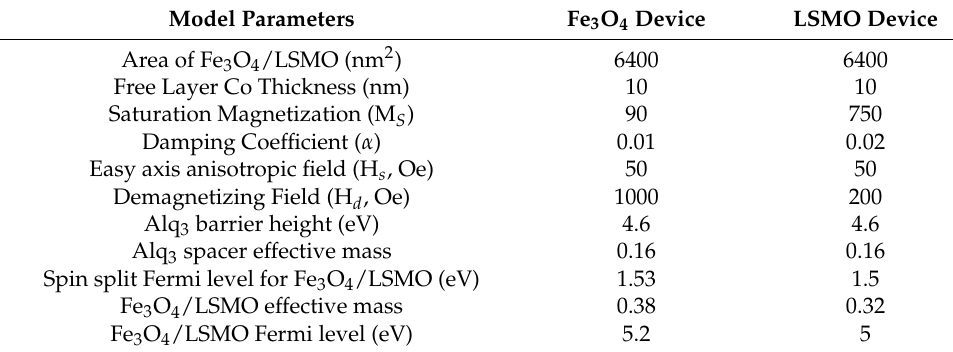
Table 3. Fe 3 O 4 /Alq 3 /Co and LSMO/Alq 3 /Co MTJ parameters for tunnel magnetoresistance (TMR)